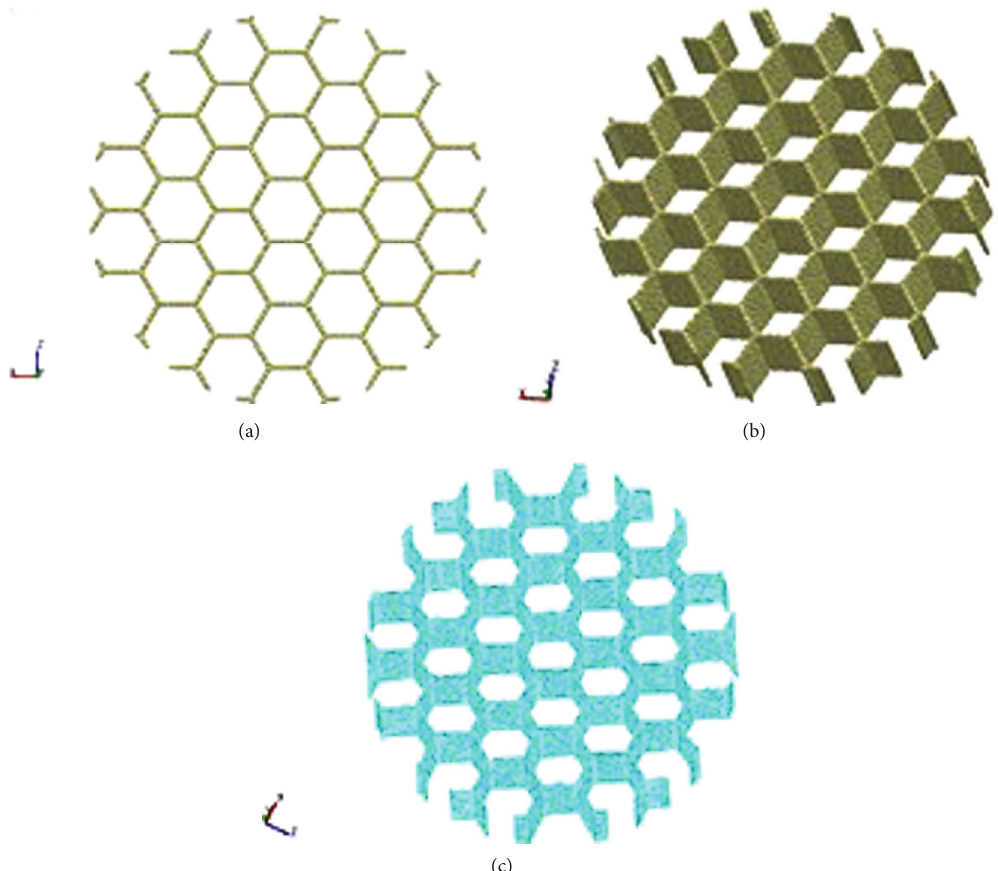
Figure 2: Discrete element model of aluminum honeycomb and its bonding structure. (a) Discrete element model of ideal Aluminum honeycomb grid. (b) Discrete element model of bent aluminum foil. (c) Discrete element model of Aluminum honeycomb structure.